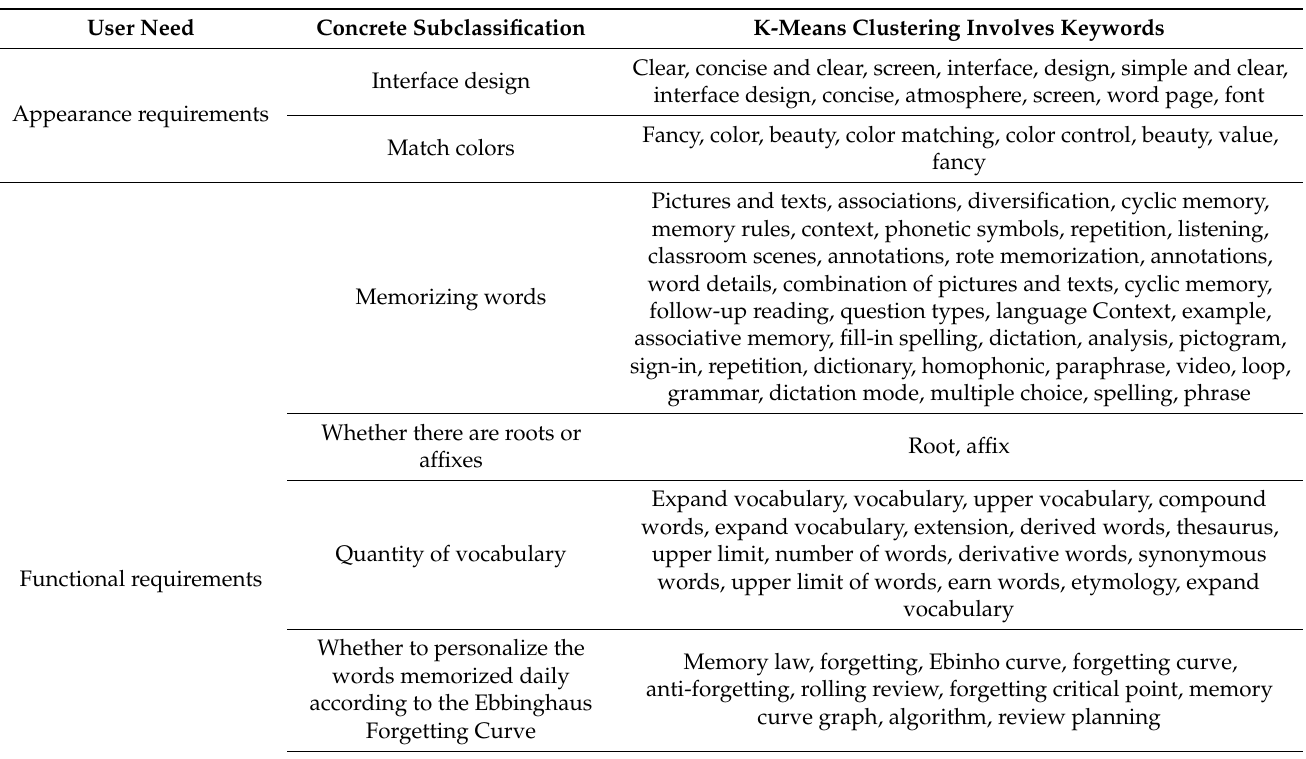
Table 7. Table of user requirement